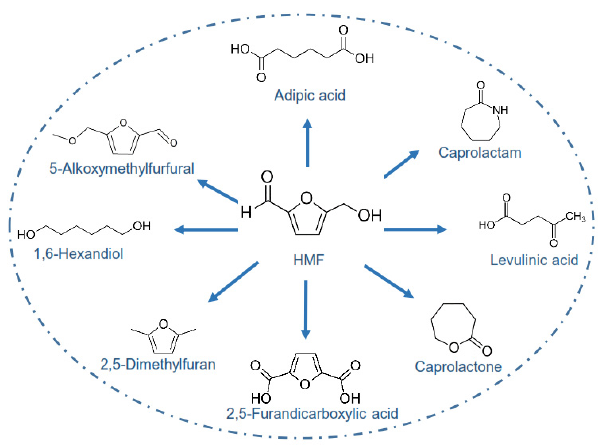
Figure 9. Some possible derivatives from 5-HMF.